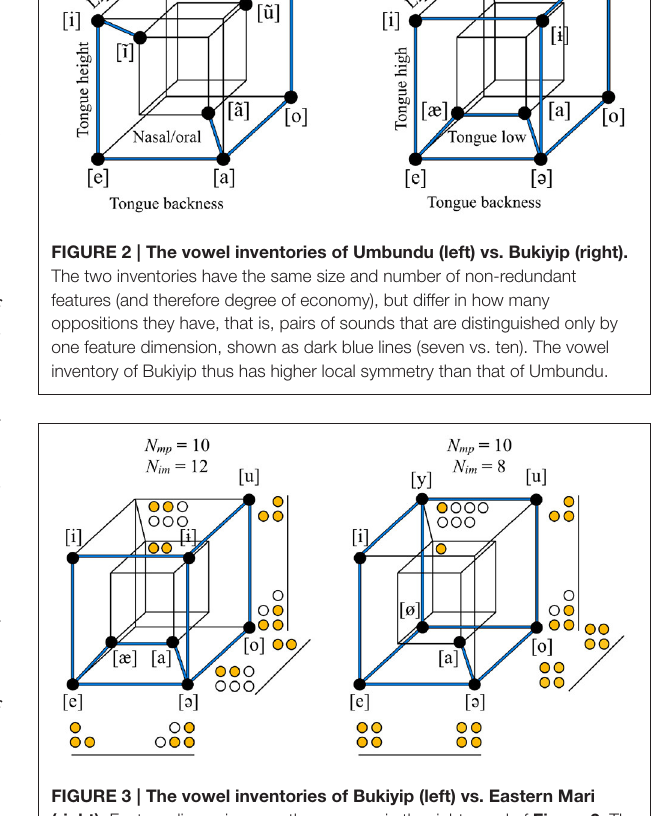
FIGURE 3 | The vowel inventories of Bukiyip (left) vs. Eastern Mari (right). Feature dimensions are the same as in the right panel of Figure 2 . The two inventories have the same size, number of non-redundant features, economy, and number of oppositions, but the level of imbalance in their distribution throughout the space differs. For each dimension, the number of sounds with each of the two values is counted using filled or empty circles; the empty circles represent the sounds that tip the balance of the given dimension toward being less equally distributed between [ + ] and [ − ]. The total number of empty circles is less in Eastern Mari than in Bukiyip, and, thus Eastern Mari has greater global